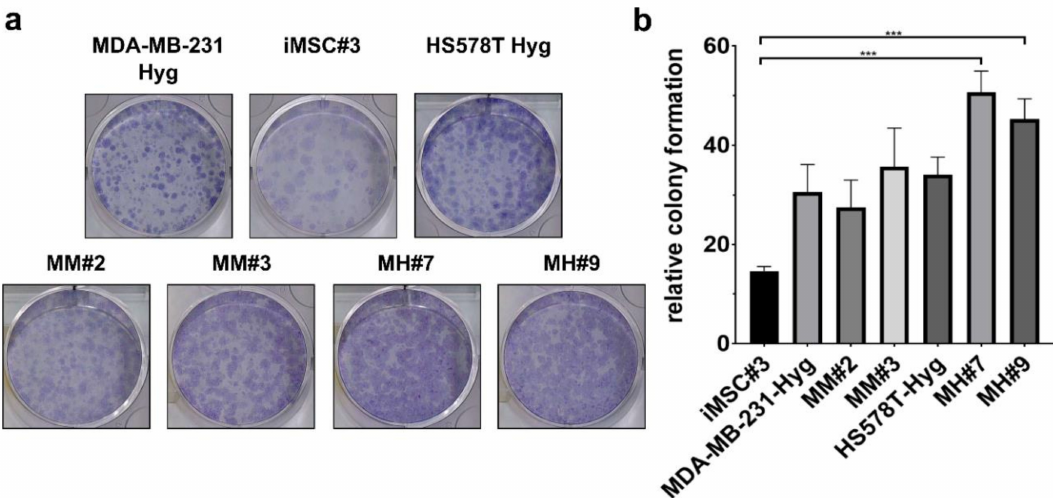
Figure 2. Analyses of di ff erent stem cell characteristics. ( a ) Representative images of colonies formed by the appropriate cell lines colored with crystal violet solution. ( b ) Examination of the mean relative formation of colonies. Statistical analysis was performed using a one-way ANOVA and post hoc Dunn’s multiple comparison test: *** = p <